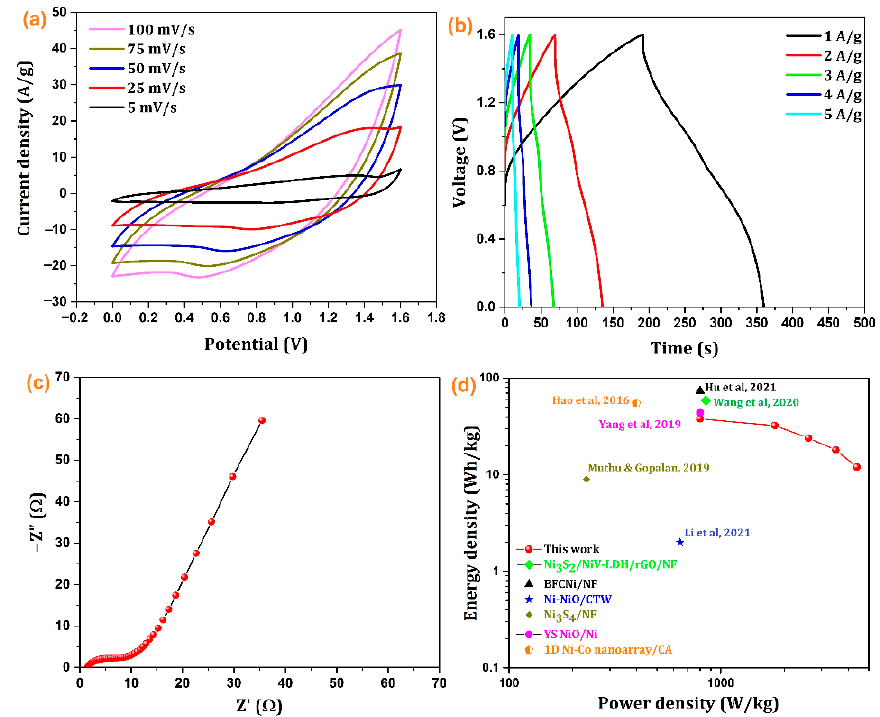
Figure 7. ( a ) CV of the device at scan rates of 5 to 100 mV/s, ( b ) GCD for the device at current densities of 1 to 5 A/g, ( c ) Nyquist plot of the device at OCV, and ( d ) Ragone plot (ED vs. PD curves) for the device at various current densities [6–11]. Table 2. The practical application of aerogel-based electrode materials and their performance comparison. System Capacitance